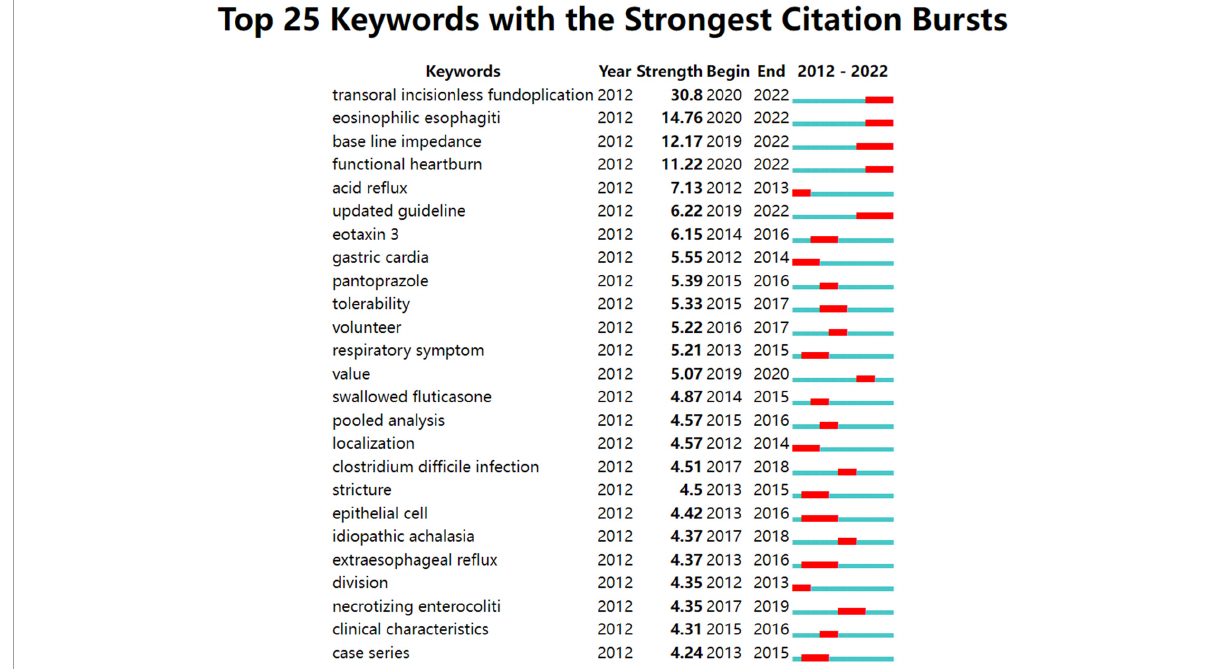
FIGURE7 Top 25 keywords with strong citation bursts in GERD research. A blue bar represents the period from 2012 to 2022, whereas red line segments represent the time slices during which keyword bursts occur, i.e., rapid increases in citation